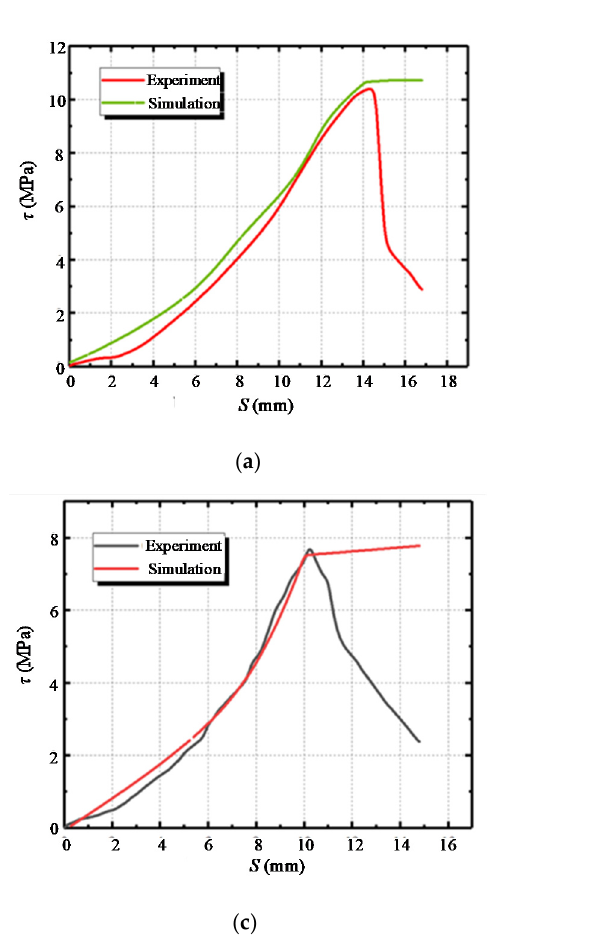
( d ) Figure 17. Von Mises stress distribution in reinforcement simulated by finite element method (MPa): ( a ) C100-0-15; ( b ) C100-5-15; ( c ) C100-0-0; ( d ) C150-0-0. 4.4. Comparative Analysis of Simulated Bond–Slip Diagrams The comparison of the experimental and simulation results of the bond–slip diagrams for specimens with different numbers of freeze–thaw cycles is shown in Figure 18. It can be